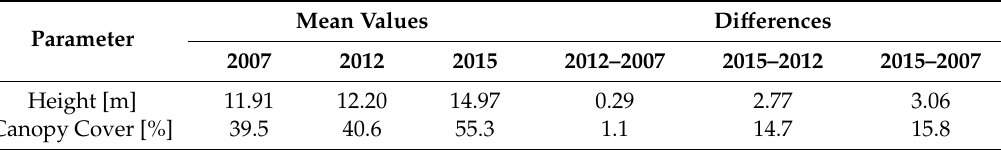
Table 2. Vegetation parameters in the forest succession